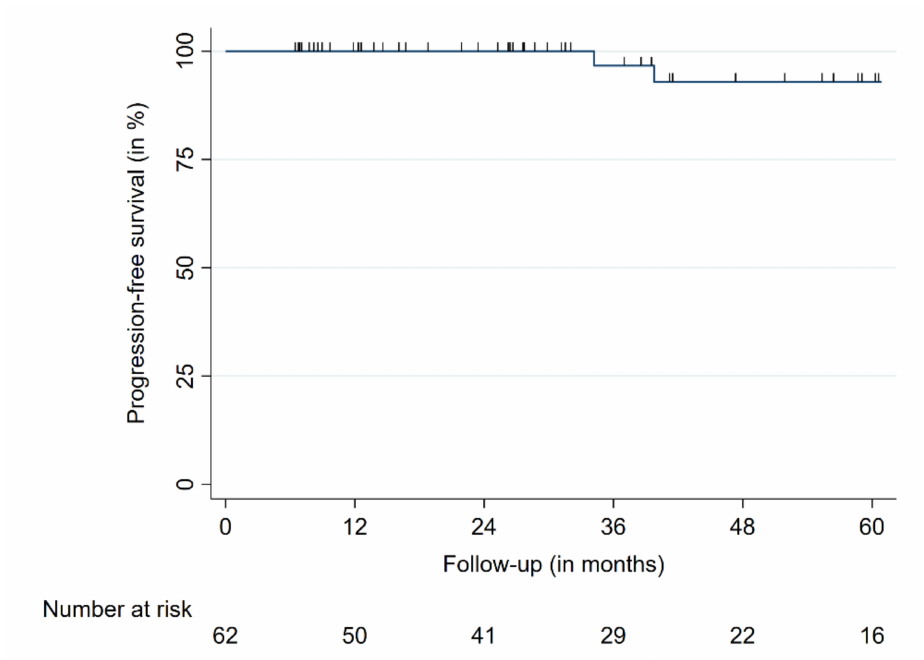
Figure 2. Progression-free